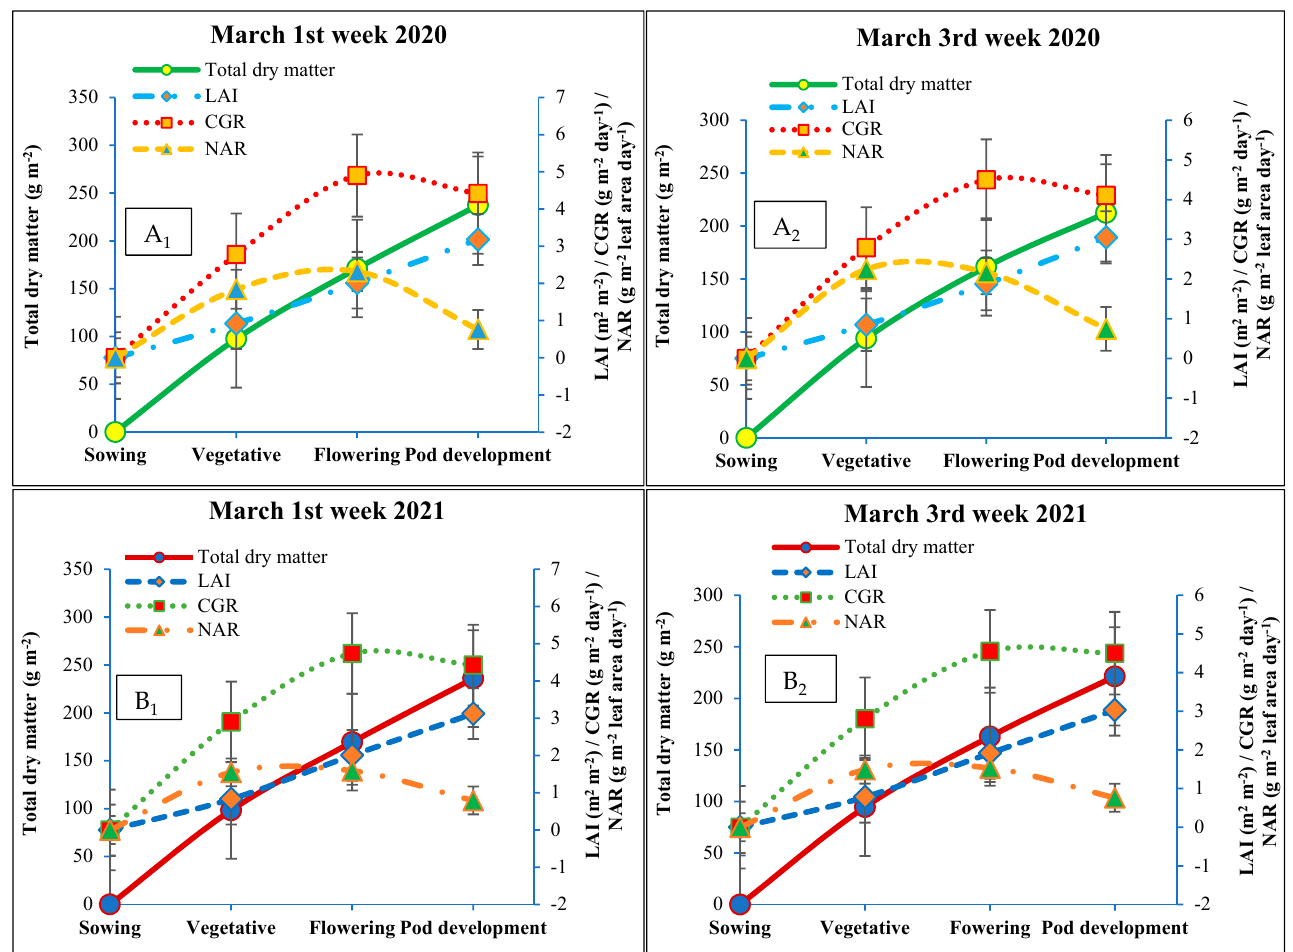
Figure 3. Growth characteristics at different phenophases under March first week sowing during ( A 1 ) 2020 and ( A 2 ) 2021 crop seasons and under March third week sowing during ( B 1 ) 2020 and ( B 2 ) 2021 crop seasons. Table 5. Growth parameters of black gram influenced by date of sowing and nutrients application.